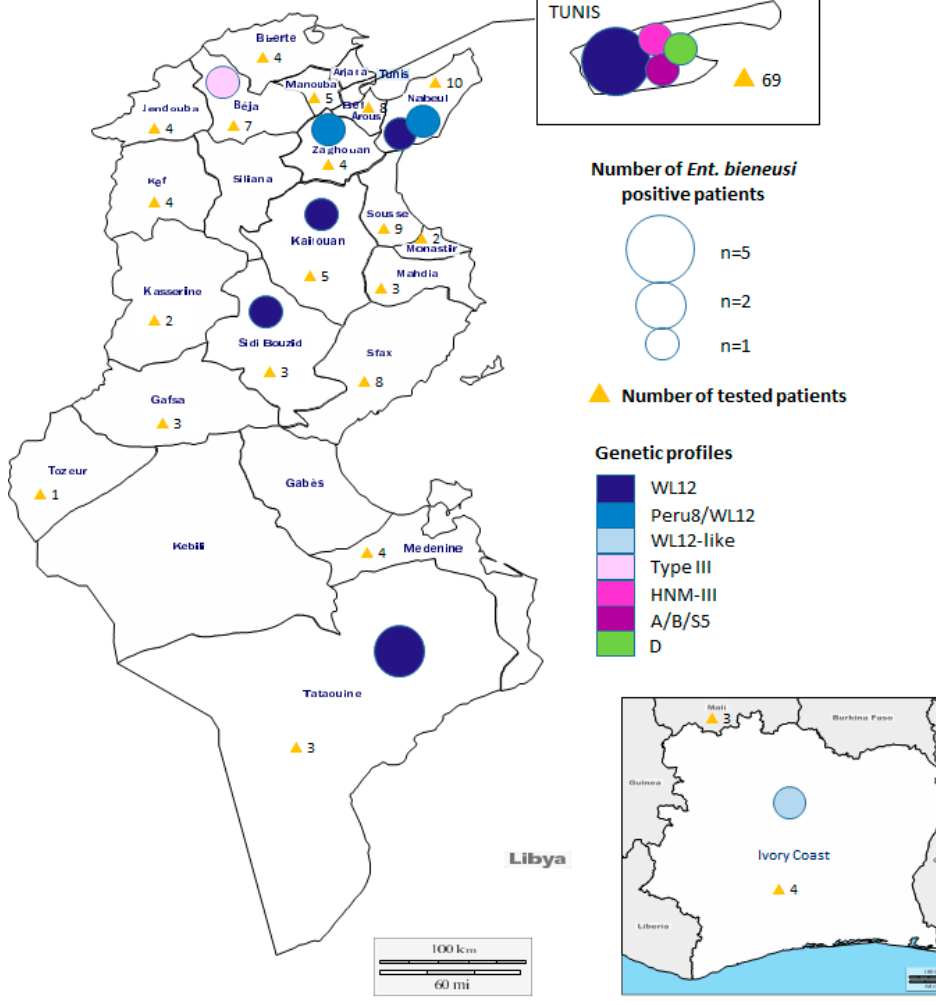
Figure 1. Geographical distribution of the genetic profiles of E . bieneusi infecting intestinal microsporidia-positive patients. The main map shows the different Tunisian districts/cities where E . bieneusi -positive patients (colored spheres) reside. The number of recruited patients originating from each district/city is indicated next to yellow triangles. Sphere sizes are proportional to the number of patients infected with E . bieneusi ( n = 1 to 5). The color of the spheres was assigned according to the identified genotypes shown on the legend with a color code, entitled “Genetic profiles”. One patient originating from Ivory Coast (bottom left map) carries E . bieneusi WL12-like genotype.